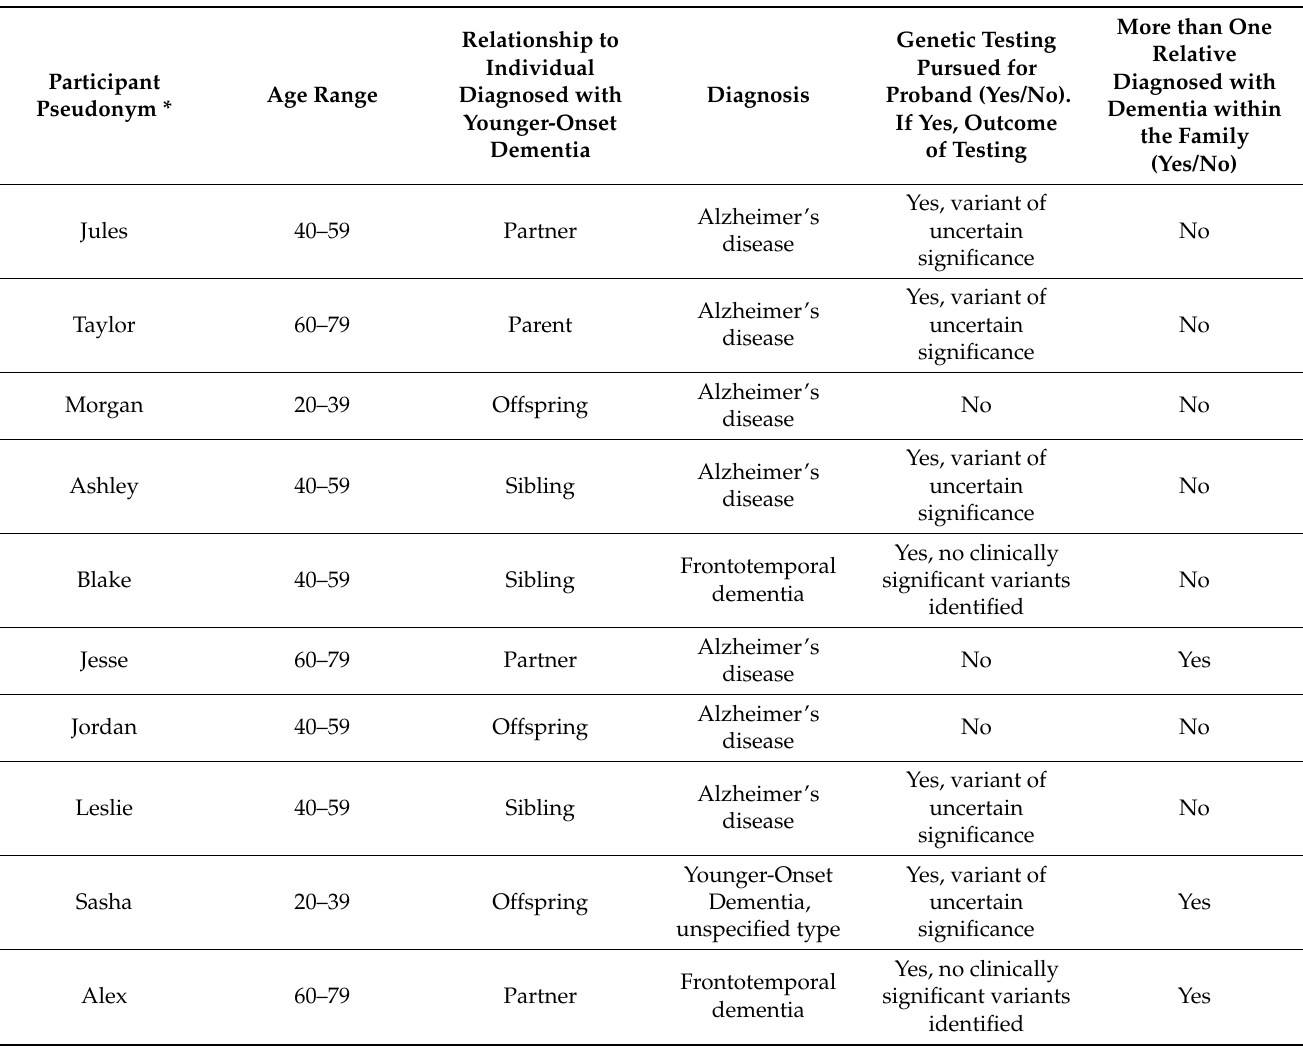
Table 1. Participant demographic